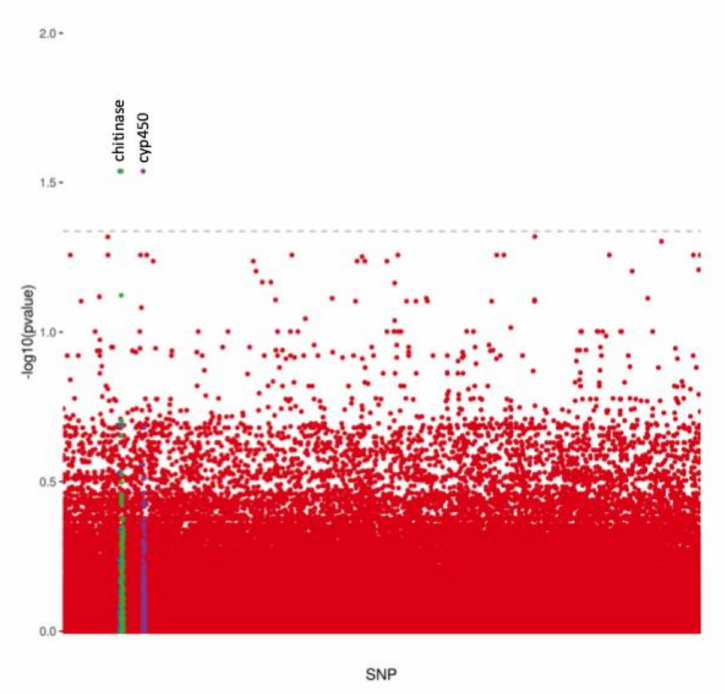
Figure 2. GWAS analysis results for Plasmodium infection . Horizontal dashed line represents the significance threshold of 0.05 for the FDR-corrected p -value. Highlighted colors represent the scaffolds containing significantly associated